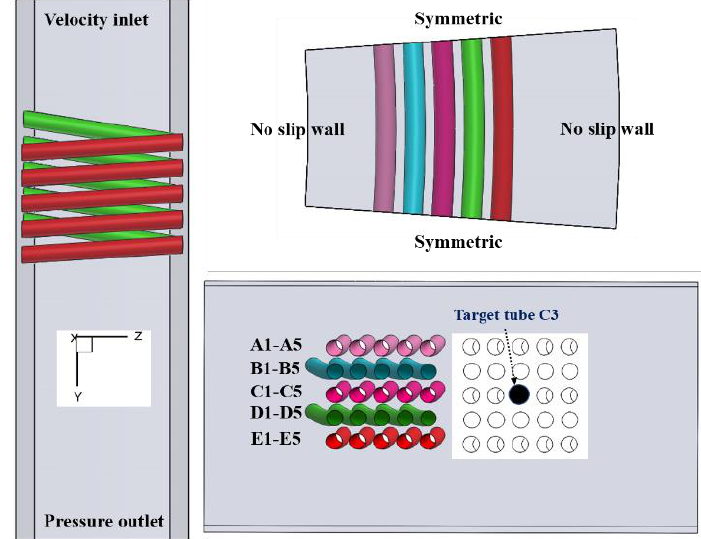
Figure 4. Helical tube arrays calculation model.